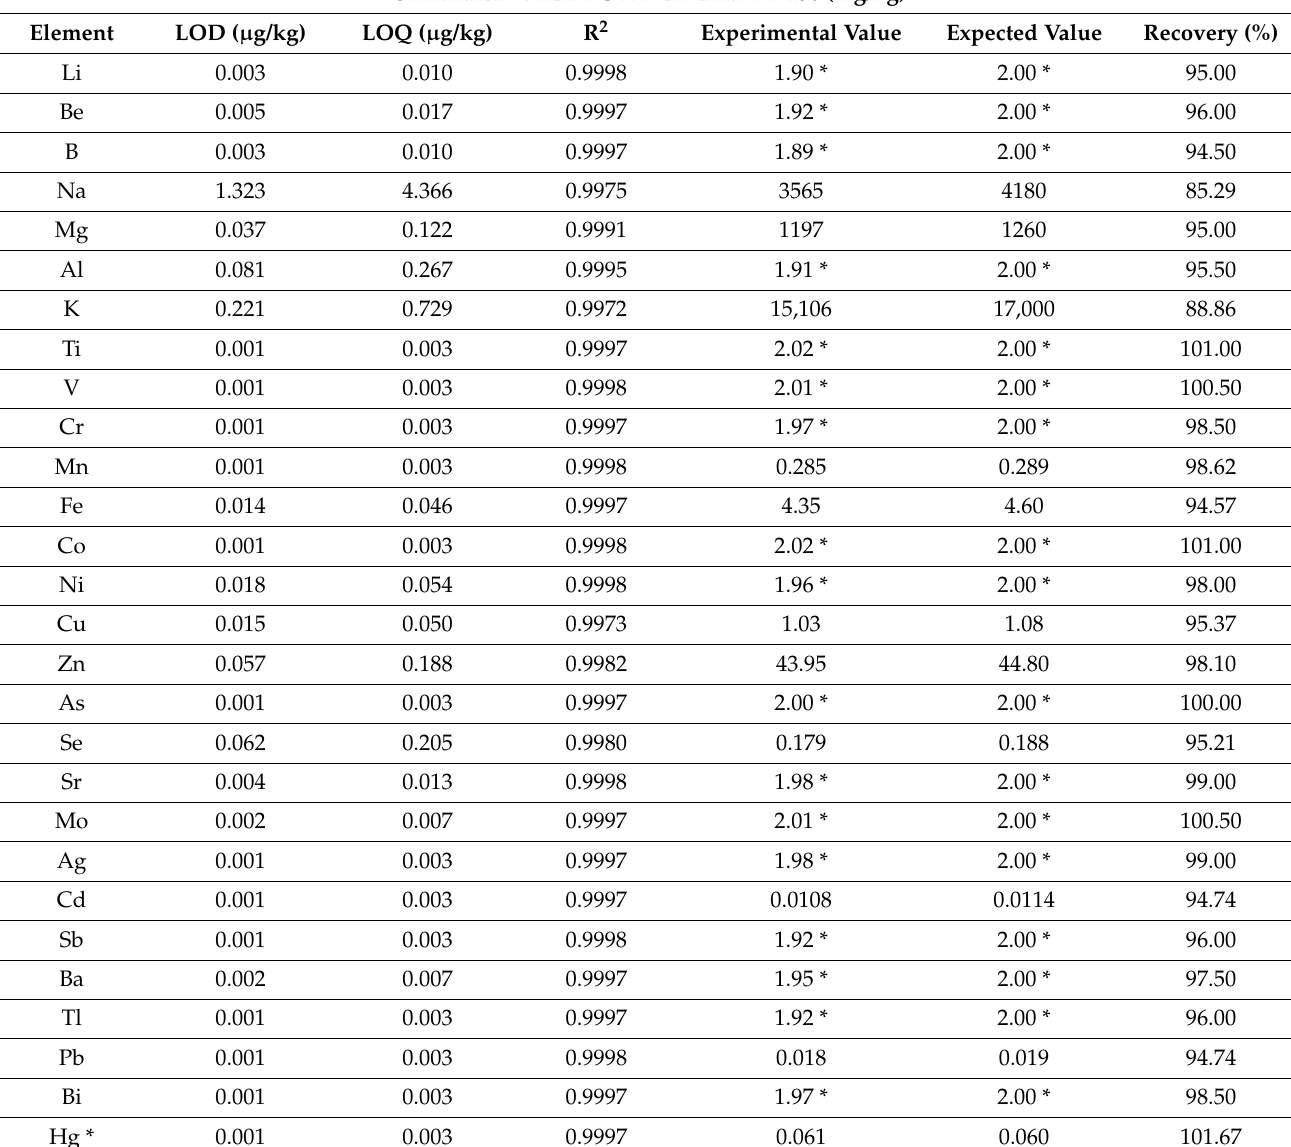
Table 3. Analytical characteristics of